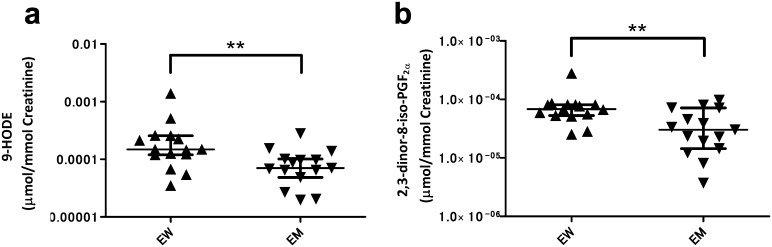
The gender-related urinary oxylipins in elderly age.Elderly women had higher concentration of 9-HODE and 2,3-dinor-8-iso-PGF2α than other groups (a and b). Closed triangles, and closed inverted triangles show elderly women (EW) and elderly men (EM), respectively. The center bars represent median area values normalized to respective creatinine level. **p < 0.01 by the Mann-Whitney U-test.